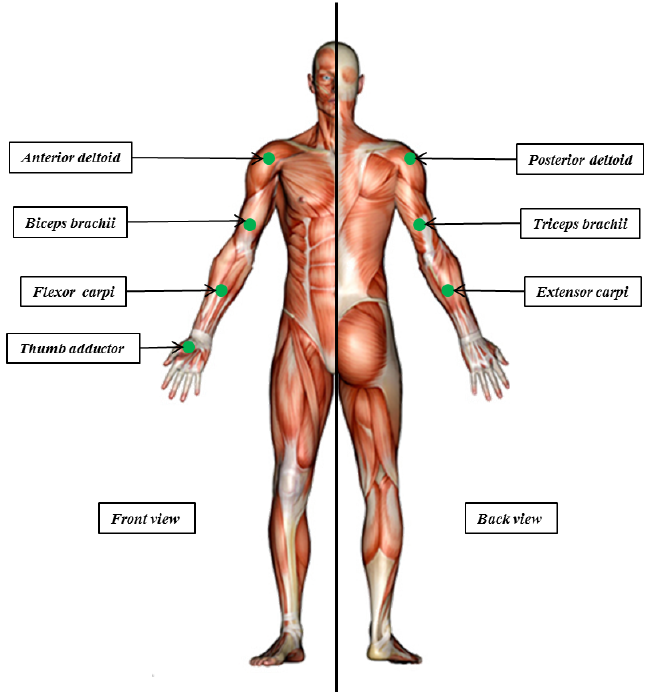
Figure 5. EMG sensors placement in different muscles of the right arm.